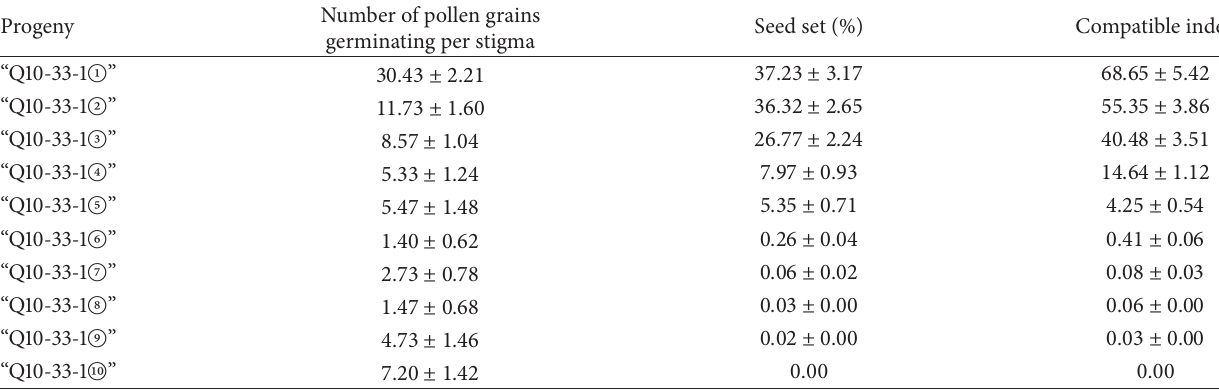
Table 3: Pistil receptivity, seed set, and compatible index of ten “Q10-33-1”s progeny.